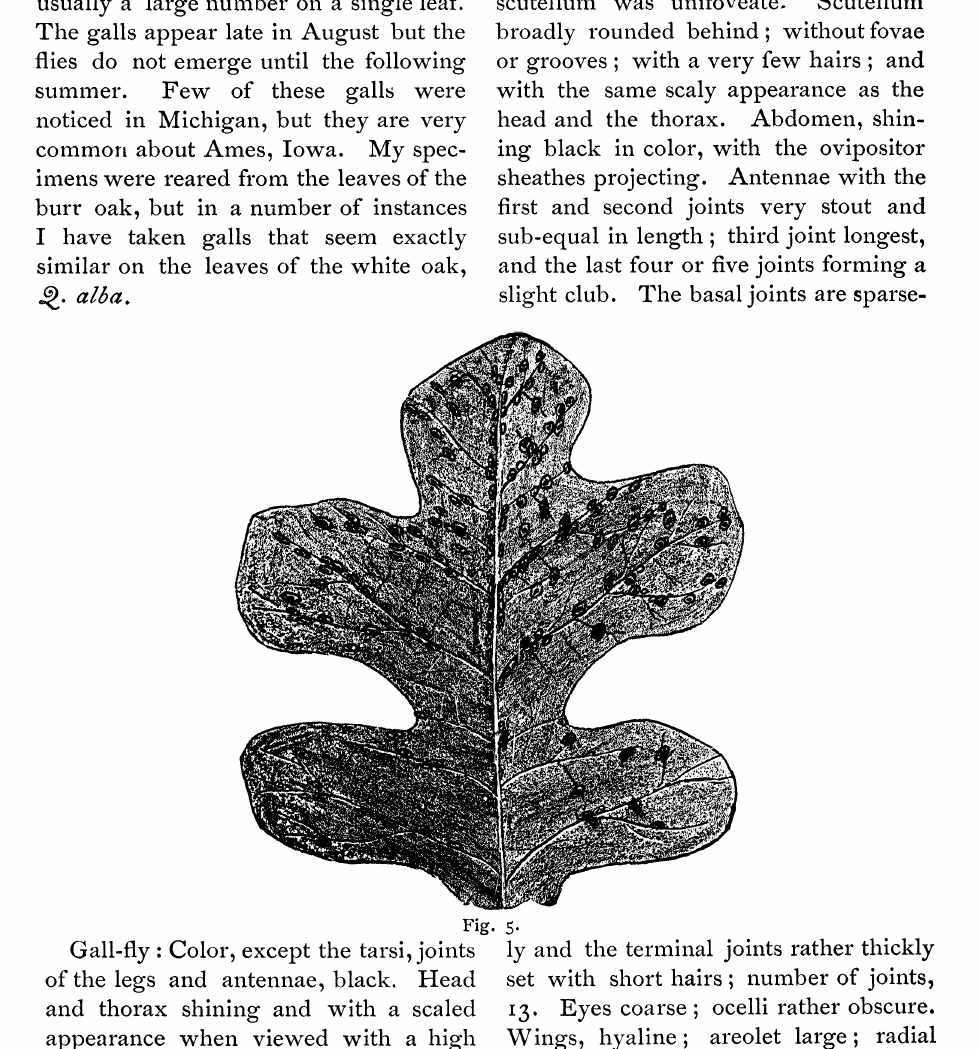
Gall-fly: Color, except the tarsi, joints of the legs and antennae, black.